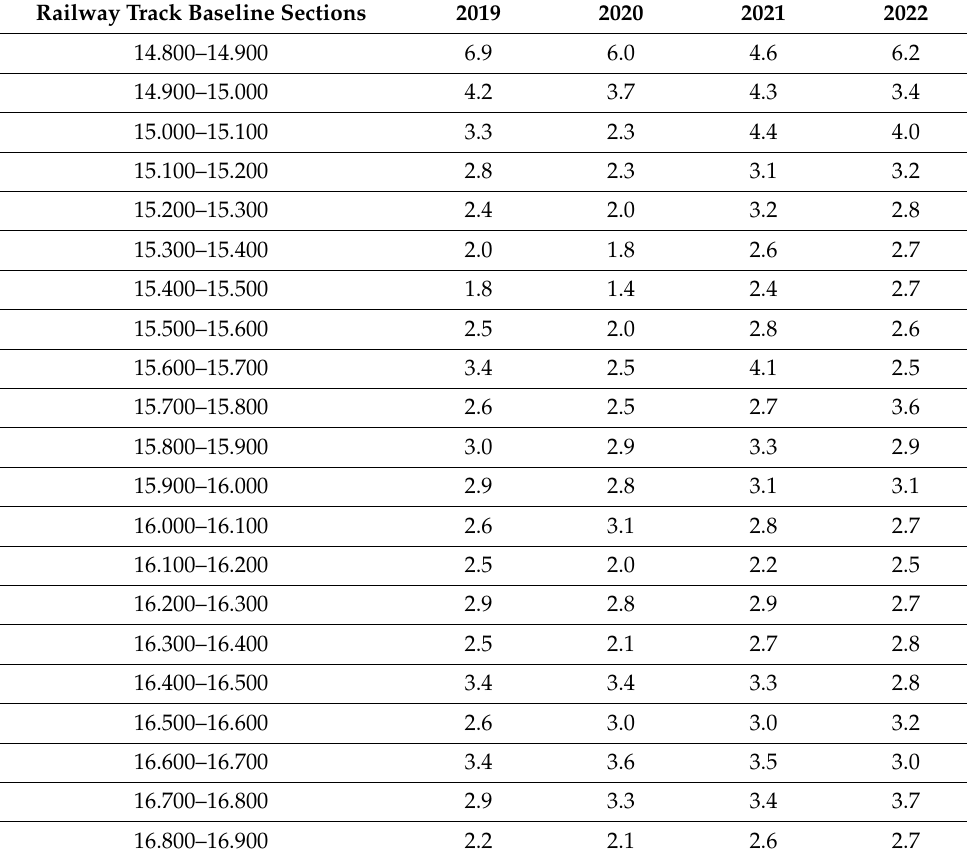
Table A3. Estimates of the railway track condition—absolute J , object No. R 144_1. Railway Track Baseline Sections